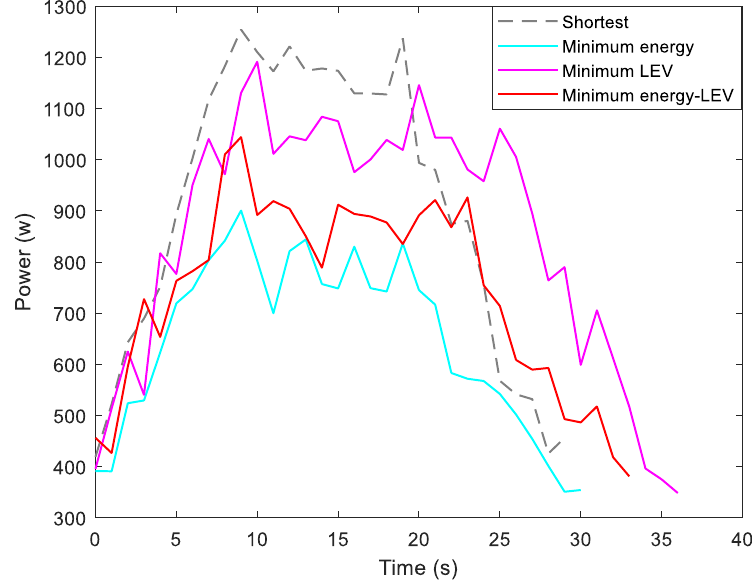
Figure 22. Motional power in the experiments.